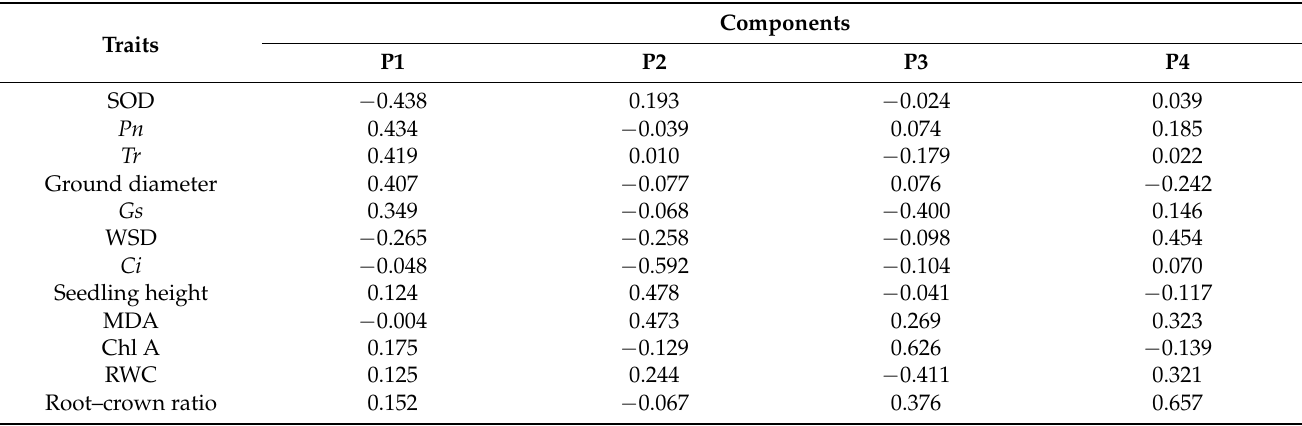
Table A8. The eigenvectors of the principal components under severe drought